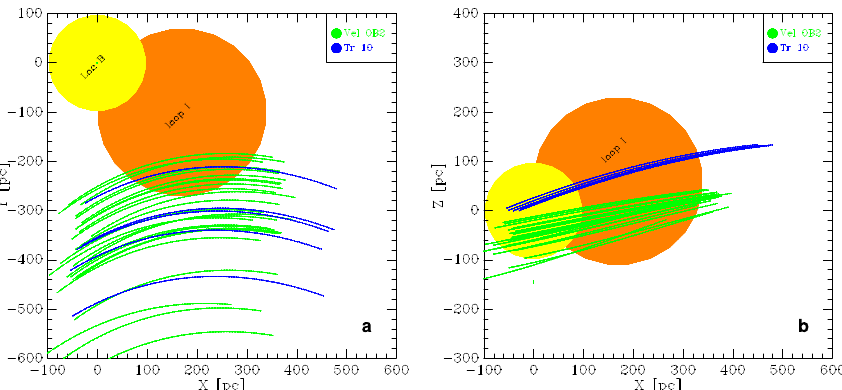
Figure 1. Calculated possible trajectories of the Loop I progenitor stars associated with Vel OB2 (green dots) and Tr 10 (blue dots), plotted together with the supposed current Local and Loop I superbubble region in projection onto a slice ( a ) along and ( b ) perpendicular to the Galactic midplane. Our solar system resides at the coordinate